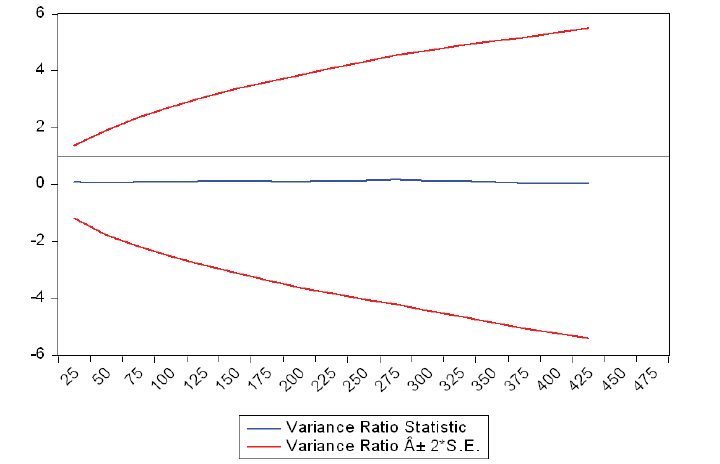
Fig. 2. Graphical illustration of the efficiency of the DSE ALSI weekly data over the test periods (December 2006 to August 2015)